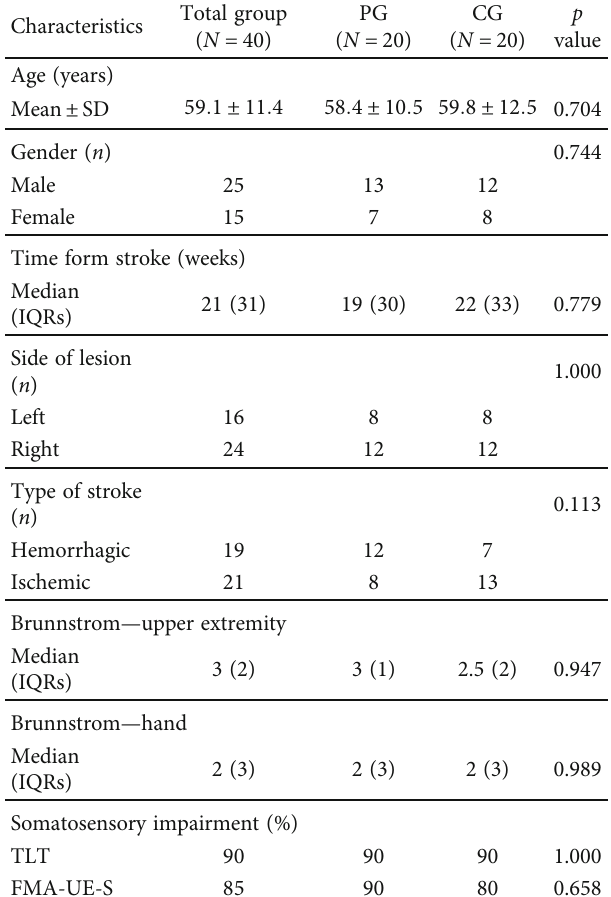
Table 1: Demographics and characteristics at baseline of the patients with